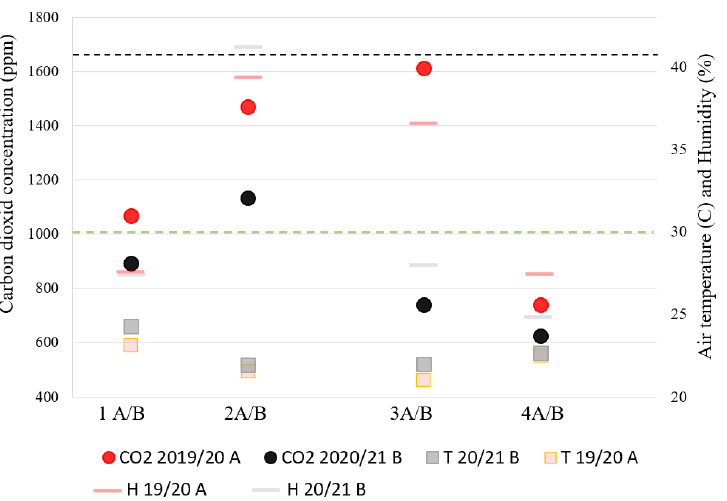
Figure 3. Measured parameters before and during the COVID-19 pandemic (CO 2 —carbon dioxide average concentration, T—air temperature, H—relative humidity; 2019–2020 A—first measuring period, 2020–2021—second measuring